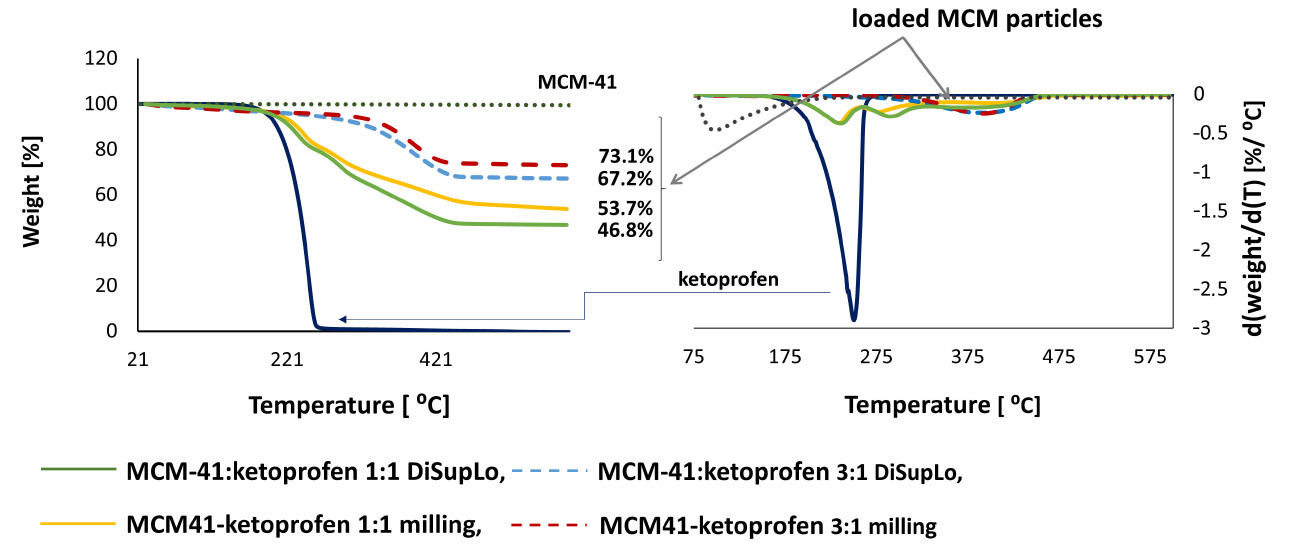
Figure 7. Illustration of TGA thermogram of native ketoprofen and ketoprofen loaded into MCM-41; ketoprofen presented a single mass loss step, with no residue at the end of the experiment, the sample does note decompose, but evaporated after melting; TGA weight% ver. temperature and 1st derivative curves show that in the samples loaded in a ratio of 1:1 there is a multi-step decomposition of ketoprofen, and in a 3:1 one-step decomposition. Data provided courtesy of Katarzyna